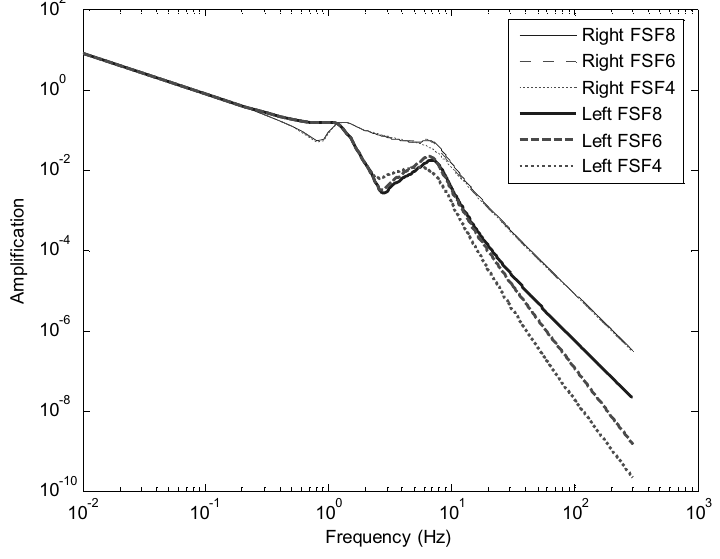
Fig. 9. Suspension deflection for right road input.